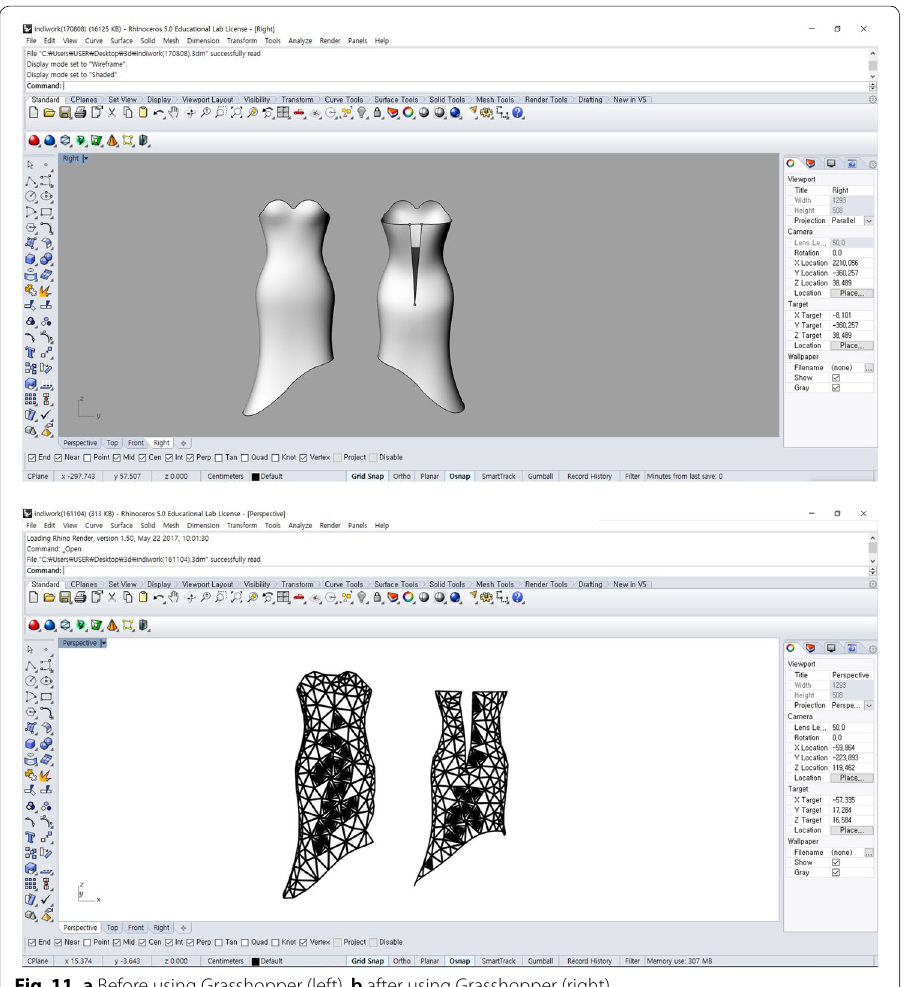
Fig. 11 a Before using Grasshopper (left), b after using Grasshopper